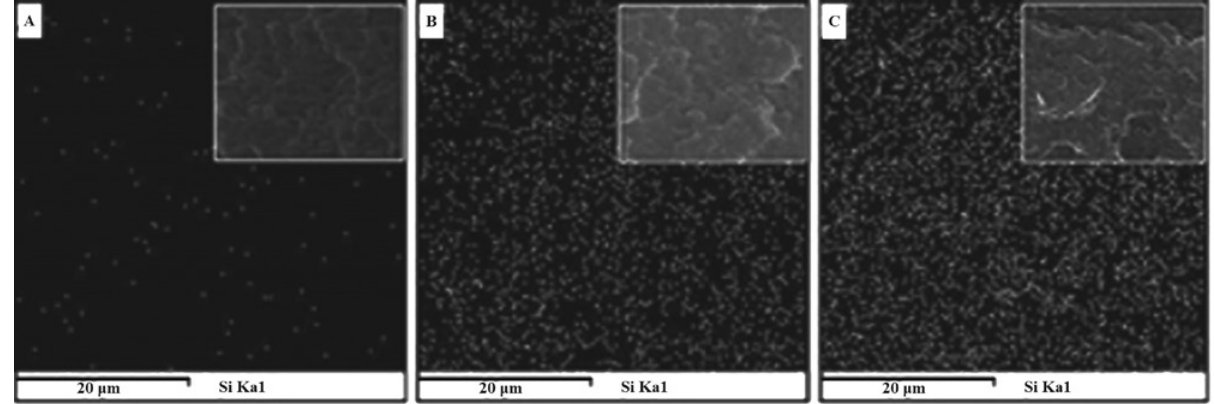
Figure 7: EDX micrographs of (A) PN3, (B) PN5, and (C) PN7 samples along with their SEM images of non-etched surface.